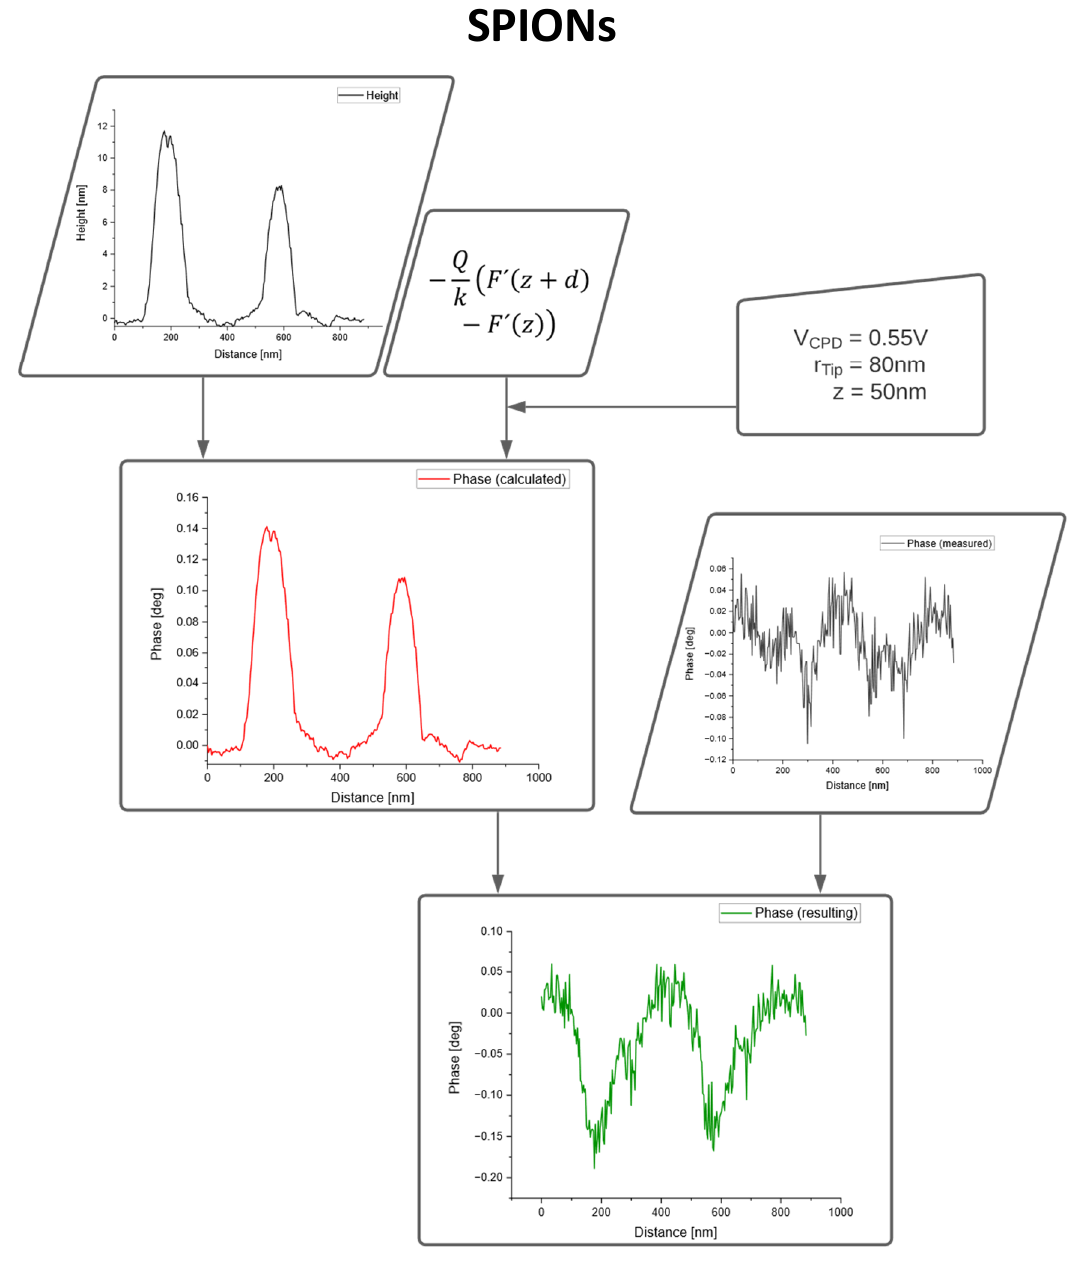
Figure 4. Data fusion of AFM topography and MFM phase image for SPIONs.